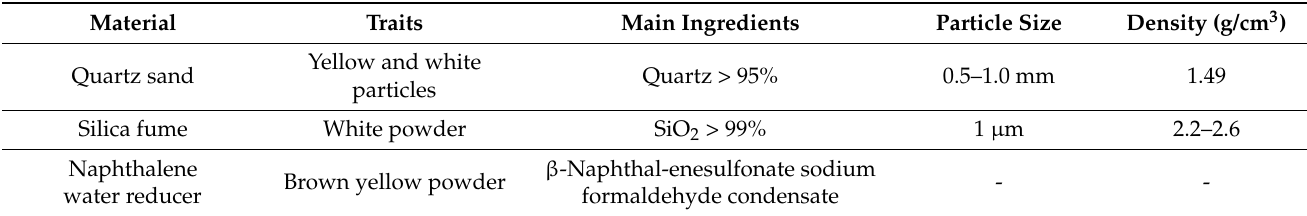
Table 2. Detailed parameters of rock-like material.